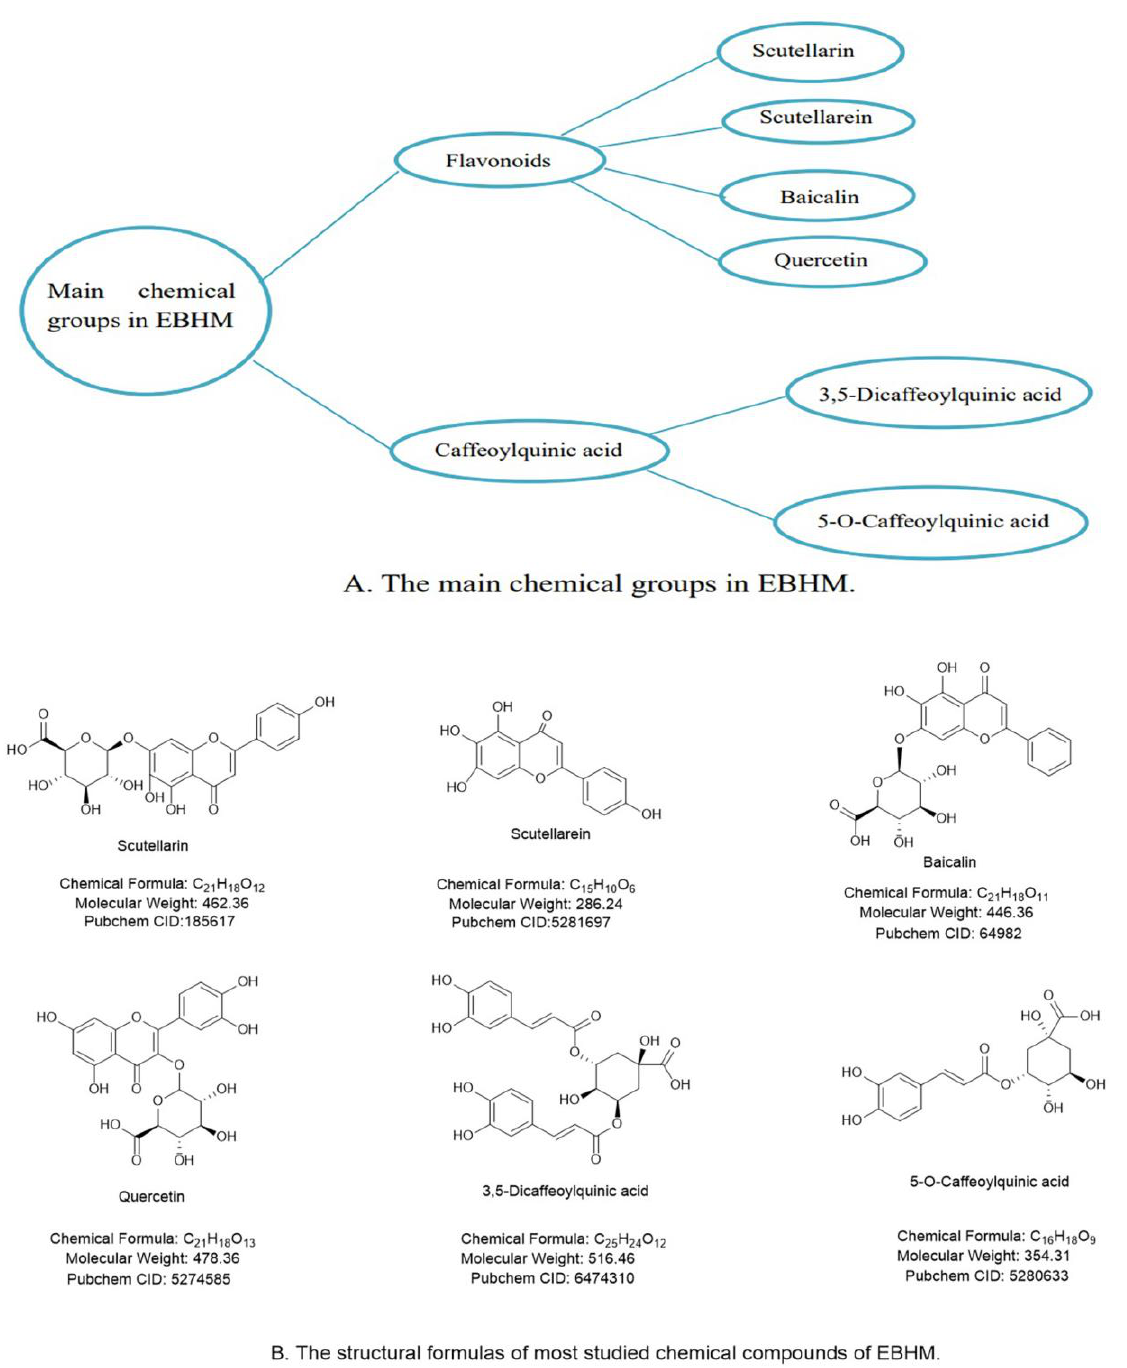
Figure 1. Active ingredients in EBHM with anti-DCD characteristics. ( A ) The main chemical groups in EBHM; ( B ) The structural formulas of most studied chemical compounds of EBHM. The major ingredient of commercially accessible preparations of EBHM is scutellarin, which is the glycosyloxyflavone with a molecular weight of 462.36[17,19]. Scutellarin has been demonstrated to ameliorate cognitive impairment, anti- amyloid β - peptide (Aβ) tox- icity, energy metabolism, suppress oxidative stress and neuroinflammation, stimulate apoptosis